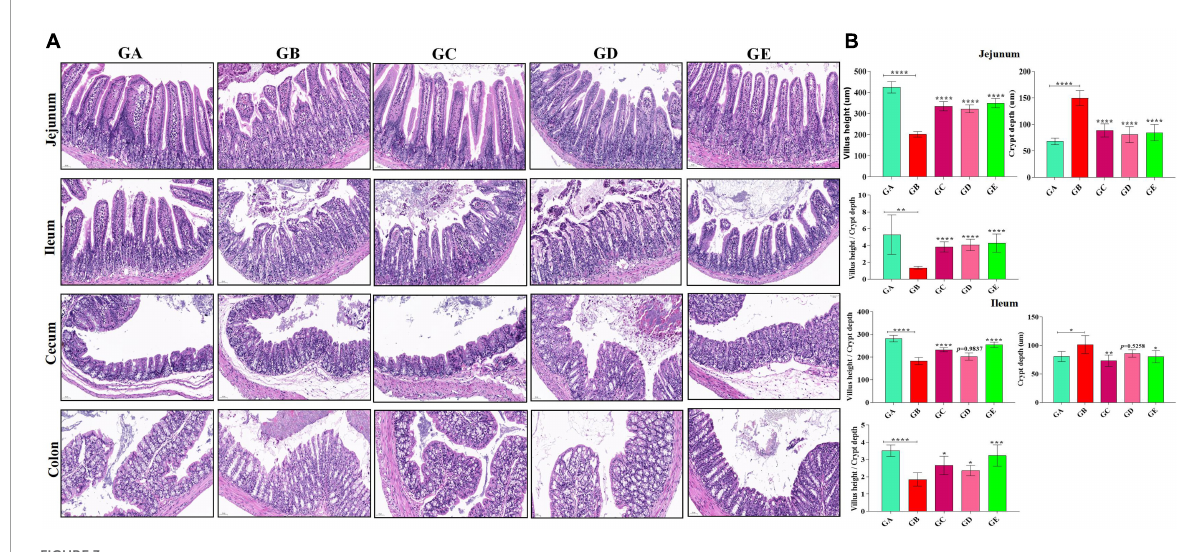
FIGURE3 Effects of BLBP on the intestine of LPS-induced mice. (A) H&E staining analysis, (B) villus height, crypt depth, and villus height/crypt depth ratio. Scale bar 50 µ m. Significance is presented as * p < 0.05, ** p < 0.01, *** p < 0.001, and **** p < 0.0001; data are presented as the mean ± SEM ( n =